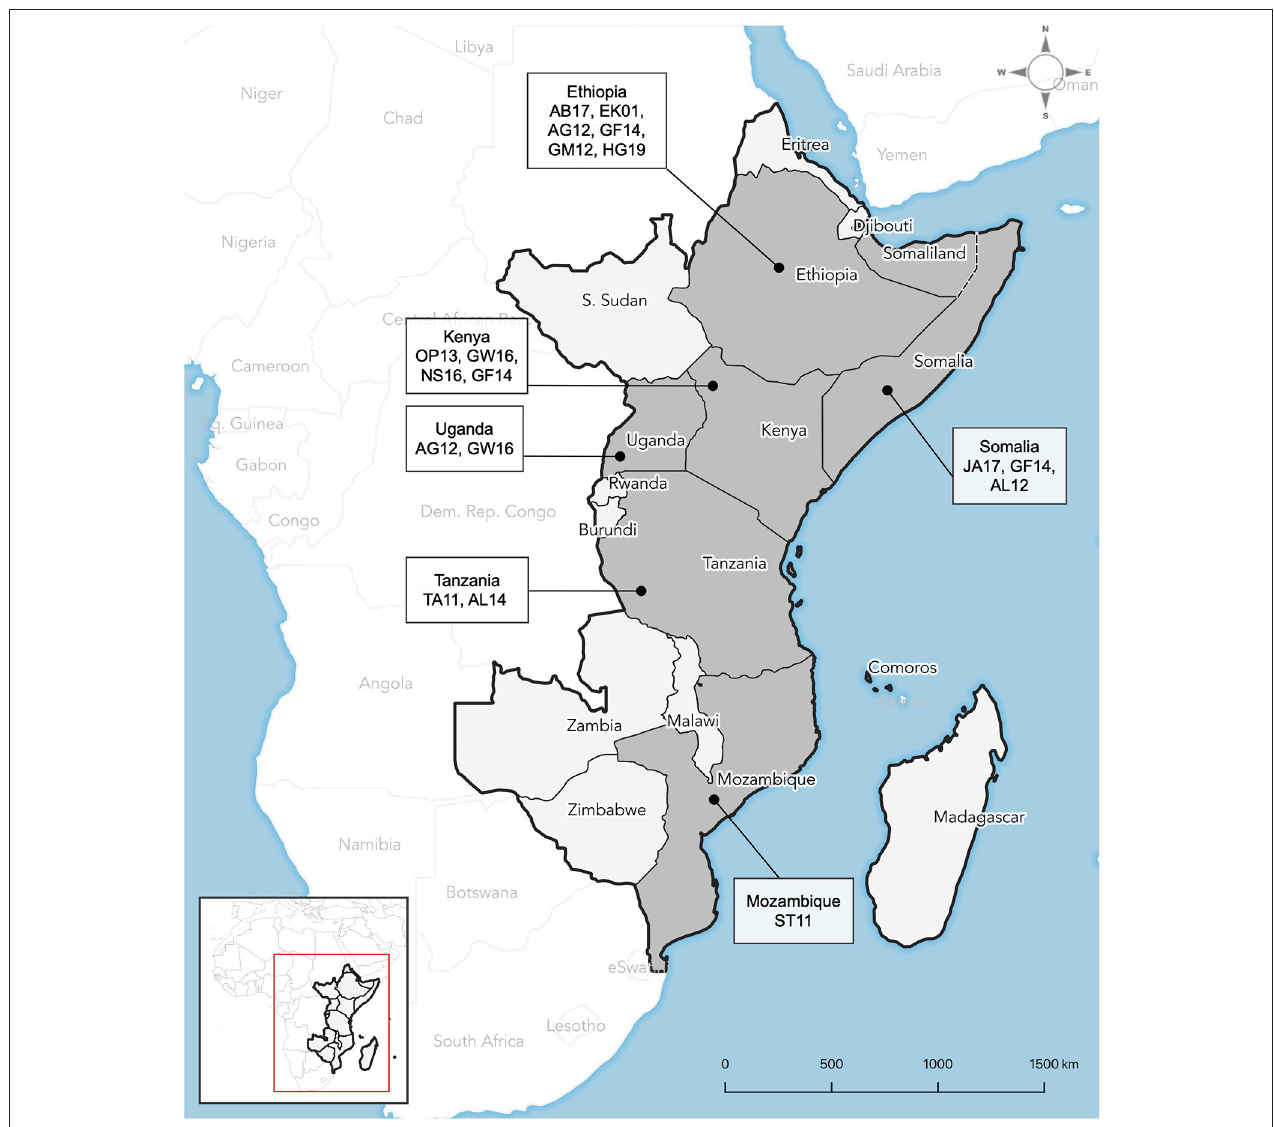
FIGURE 1 | Map of case study locations across East Africa. Dark grey indicates country case studies included in the